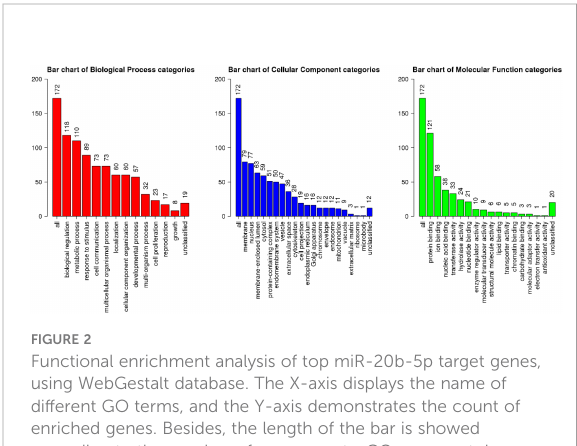
FIGURE 2 Functional enrichment analysis of top miR-20b-5p target